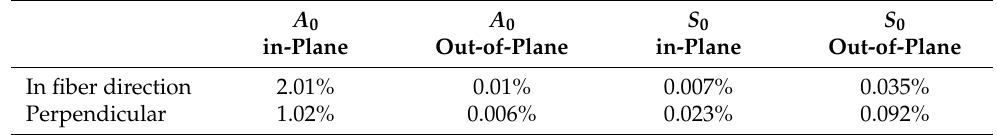
Table A1. Calculated mean error for the 2D model at 80kHz.